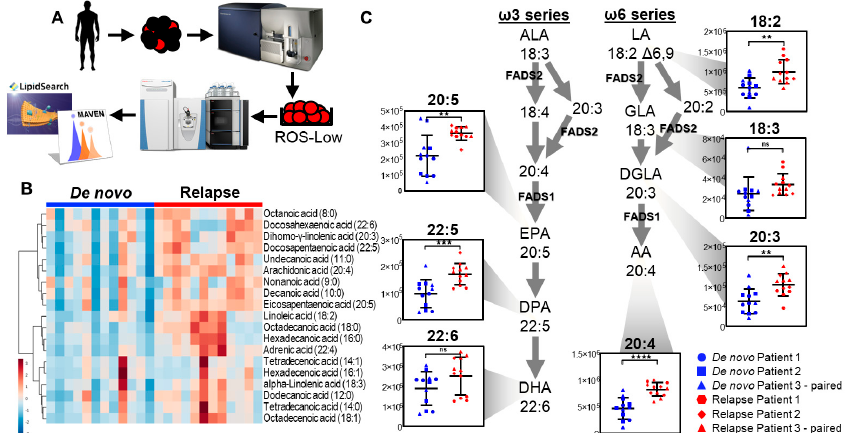
Figure 1. Relapsed LSCs display an aberrant fatty acid metabolism. ( A ) De novo and relapse AML cells were obtained from AML patient leukapheresis product. Flow cytometry was used to isolate ROS-Low leukemic stem cells (LSCs). LSCs were then subjected to mass spectrometry for global metabolomics and lipidomics analyses. ( B ) Heatmap of free fatty acid levels in de novo and relapsed AML LSCs. Metabolomics analysis was performed with n = 3 patient samples with 4 technical replicates. (de novo patients 1, 2, and 3 and relapsed patients 1, 2, and 3). ( C ) Free fatty acids within the ω 3 and ω 6 fatty acid desaturation pathways in de novo and relapsed AML LSCs. Metabolomics analysis was performed with n = 3 patient samples with 4 replicates. Patient samples are identified using different shapes, with the single paired patient sample both identified as triangles (de novo patients 1, 2, and 3 and relapsed patients 1, 2, and 3). ns p > 0.05, ** p ≤ 0.01, *** p ≤ 0.001, **** p ≤